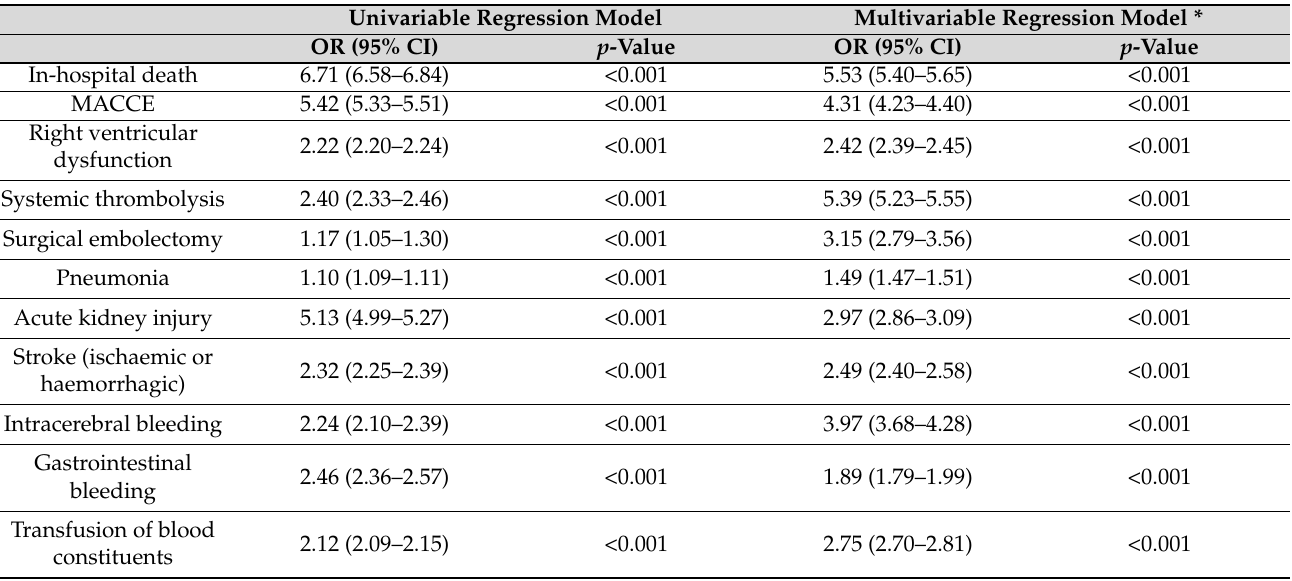
Table 4. Prognostic value of the CRB-65 high-risk class for prediction of adverse in-hospital events. Association of high-risk class with the adverse in-hospital events (univariable and multivariable logistic regression